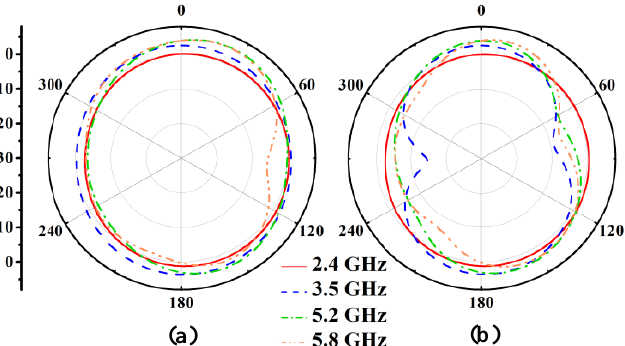
Figure 8. Simulated radiation patterns of the proposed ATPA at ( a ) xoz -plane, ( b ) yoz -plane. For the ATPA, there are two main current paths on either side of the asymmetric tuning fork structure, the equivalent electrical lengths of which are approximately equal to (L2 + L4) and (L3 + L5), respectively. According to the formula [17]: f = c/4 L (c is the speed of light in free space; and L is the electrical length.), it can be calculated that the two resonant points of the antenna are about 2.31 and 3.3 GHz, which are consistent with the simulation results in Figure 7. Therefore, we need to design a new current path with a length between 22.5 mm and 32.5 mm to enhance the low frequency resonance charac- teristics. However, the return loss only reaches −1 0 dB in the range of 5 to 6 GHz, and thus the introduction of a new structure is likely to worsen the return loss in this range. Thus, we need to subtly design a new structure, which could not only improve the re- flection characteristics of both low and high frequency regions but also maintain the current size. Based on the analysis above, we proposed a novel tuning fork-shaped tri-band pla- nar antenna (NTTPA) by meticulously adding an inverted L-shaped radiation patch on the ground of the ATPA. In addition, the L-shaped patch is designed on the short side of the turning fork-shaped patch to compensate for the radiation asymmetry caused by the asymmetric turning fork structure. The antenna is optimized by adjusting L 7 and L 8 , and the final structure size is shown in Table 1. The simulated surface current distributions under 2.4 and 5.8 GHz are given in Figure 9 to illustrate the operating mechanism for the ATPA and NTTPA. The larger value of the current distribution is indicated in red, and the smaller value is in blue. It can be seen that the introduction of the inverted L-shaped structure not only provides a new